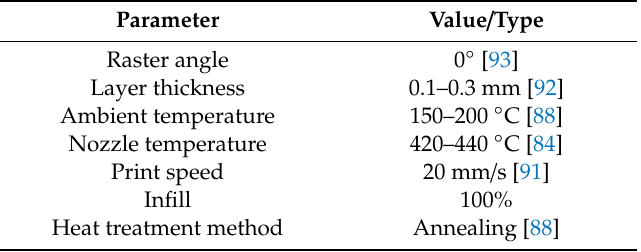
Table 7. Recommended values of the parameters for FFF 3D-printing of